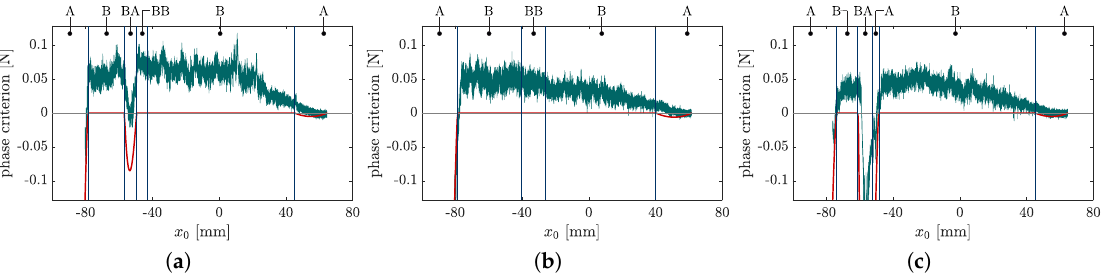
Figure 7. Unit related representation of phase criterion (20) for distinguishing phase A&BA from B&BB plotted against the support position x 0 (red: simulated data, green: experimental data, vertical black lines: phase transitions): scanning the objects O1 ( a ), O2 ( b ) and O3 ( c